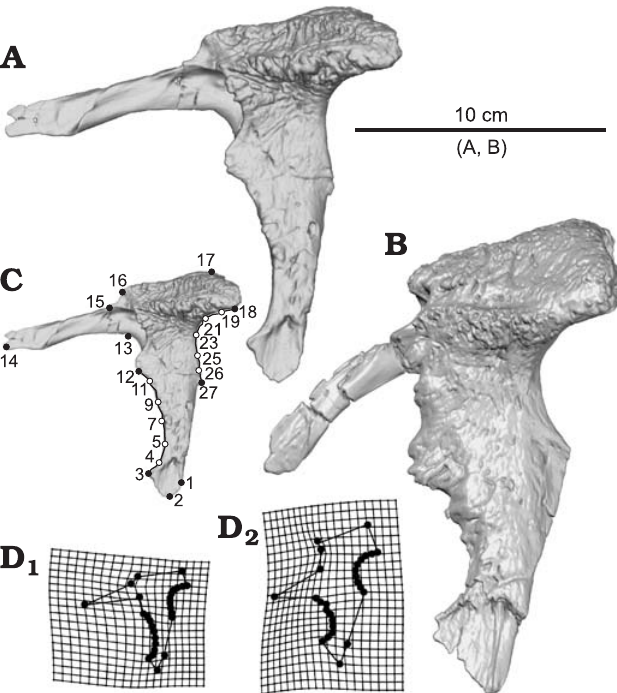
Fig. 5. Representative lacrimals (rendered CT images) of Majungasaurus crenatissimus (Depéret, 1896) Lavocat, 1955 from the Maastrichtian (Upper Cretaceous) Maevarano Formation, northwestern Madagascar in left lateral view. A . UA 9944. B . FMNH PR 2100. C . Illustration of land- mark positions used for lacrimals. Black circles, landmarks; white circles interconnected with solid lines, semilandmarks. D . Ontogenetic shape change visualized by deformation grids relative to average; outline of smallest (D 1 ) and largest (D 2 ) specimens from